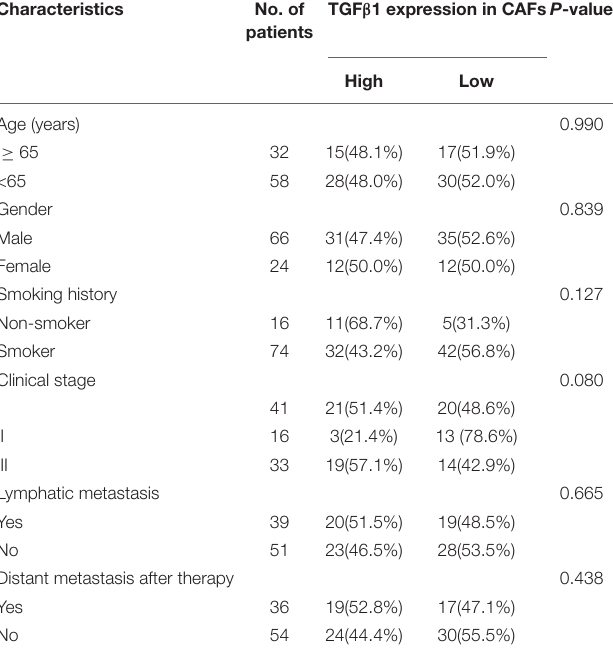
TABLE 1 | Clinical features of the study population. Characteristics